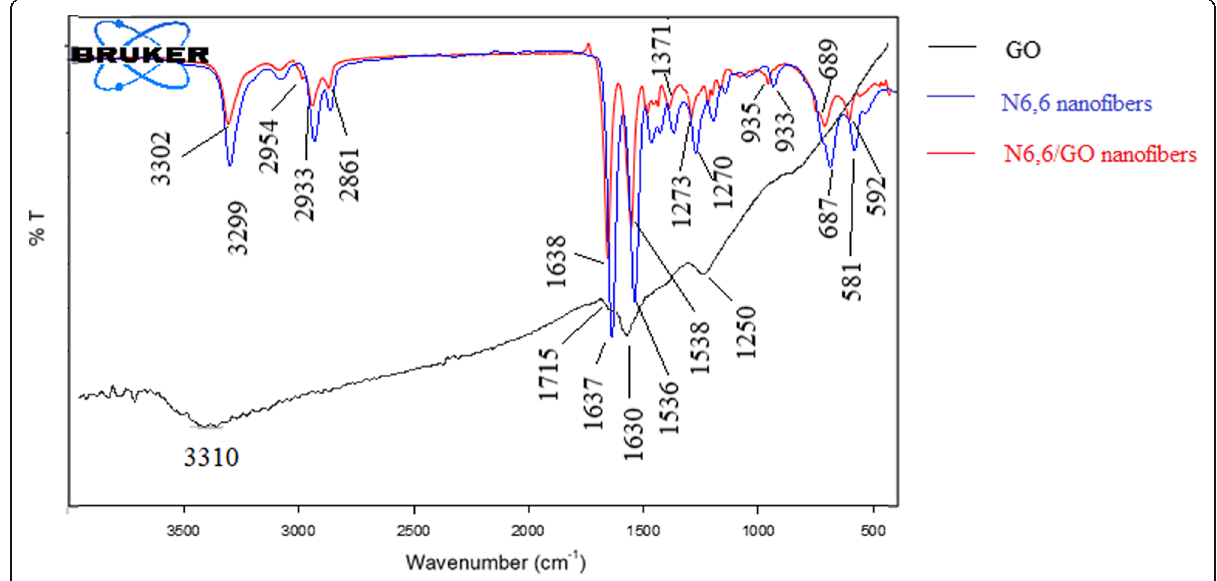
Fig. 4 Fourier-transform infrared spectroscopy (FT-IR) spectra of N6,6 nanofibers, GO, and N6,6/GO